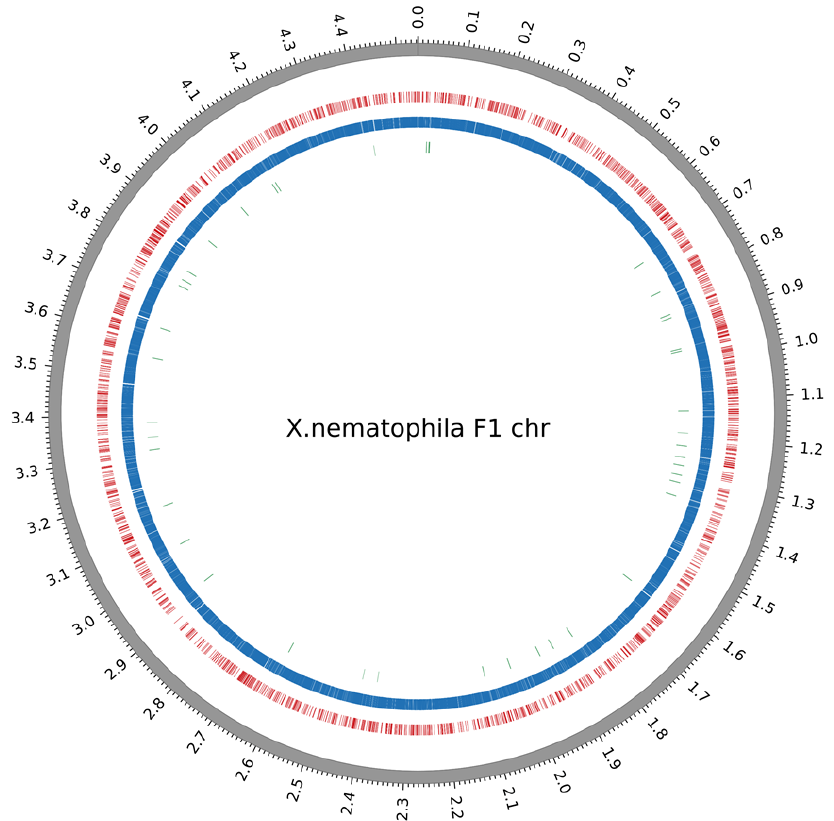
Figure 2. Circos plots displaying the distribution of methylated bases over the X. nematophila F1 chromosome . Outermost track displays the genomic positions in megabases. The colored tracks display the location of the modification marks detected, for each of the 4 identified motifs. From outer to inner: red, CAGNNNNNGTG/CACNNNNNCTG; blue, GATC; green, AANNNCCGGG-NNNNNGA.